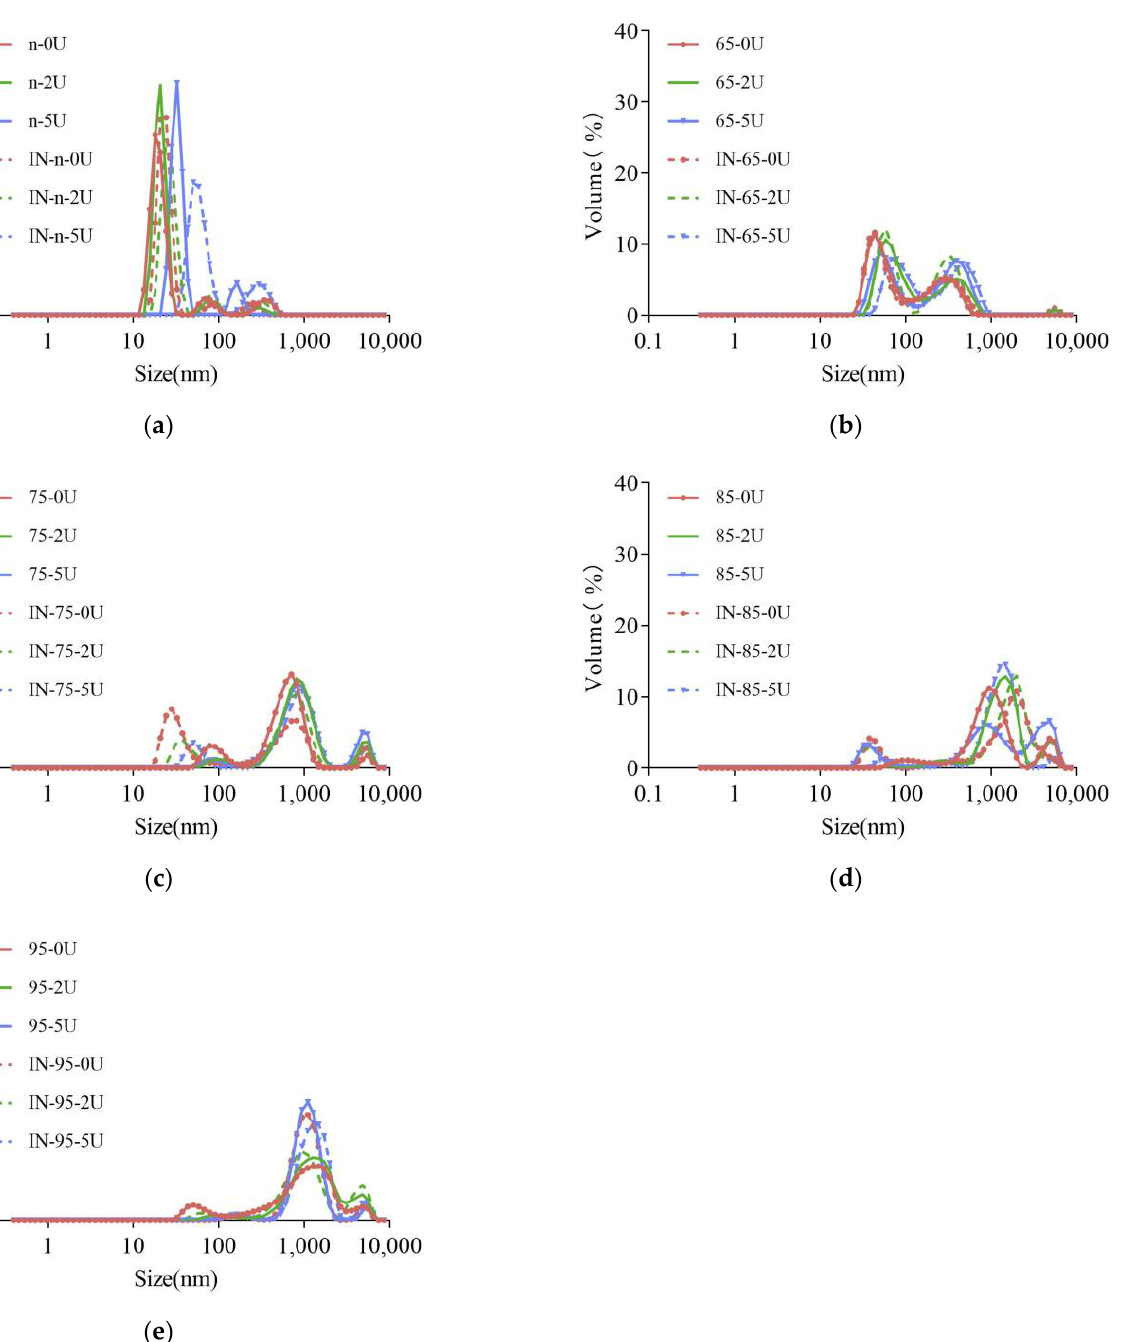
Figure 2. Particle size distribution of SPI samples. Samples after inactivating the PG named IN-n-0U, IN-n-2U, IN-n-5U, IN-65-0U, IN-65-2U, IN-65-5U, IN-75-0U, IN-75-2U, IN-75-5U, IN-85-0U, IN-85-2U, IN-85-5U, IN-95-0U, IN-95-2U, IN-95-5U, respectively. ( a ): native SPI with different PG-treated levels; ( b ): preheated SPI at 65 ◦ C with different PG-treated levels; ( c ): preheated SPI at 75 ◦ C with different PG-treated levels; ( d ): preheated SPI at 85 ◦ C with different PG-treated levels; ( e ): preheated SPI at 95 ◦ C with different PG-treated